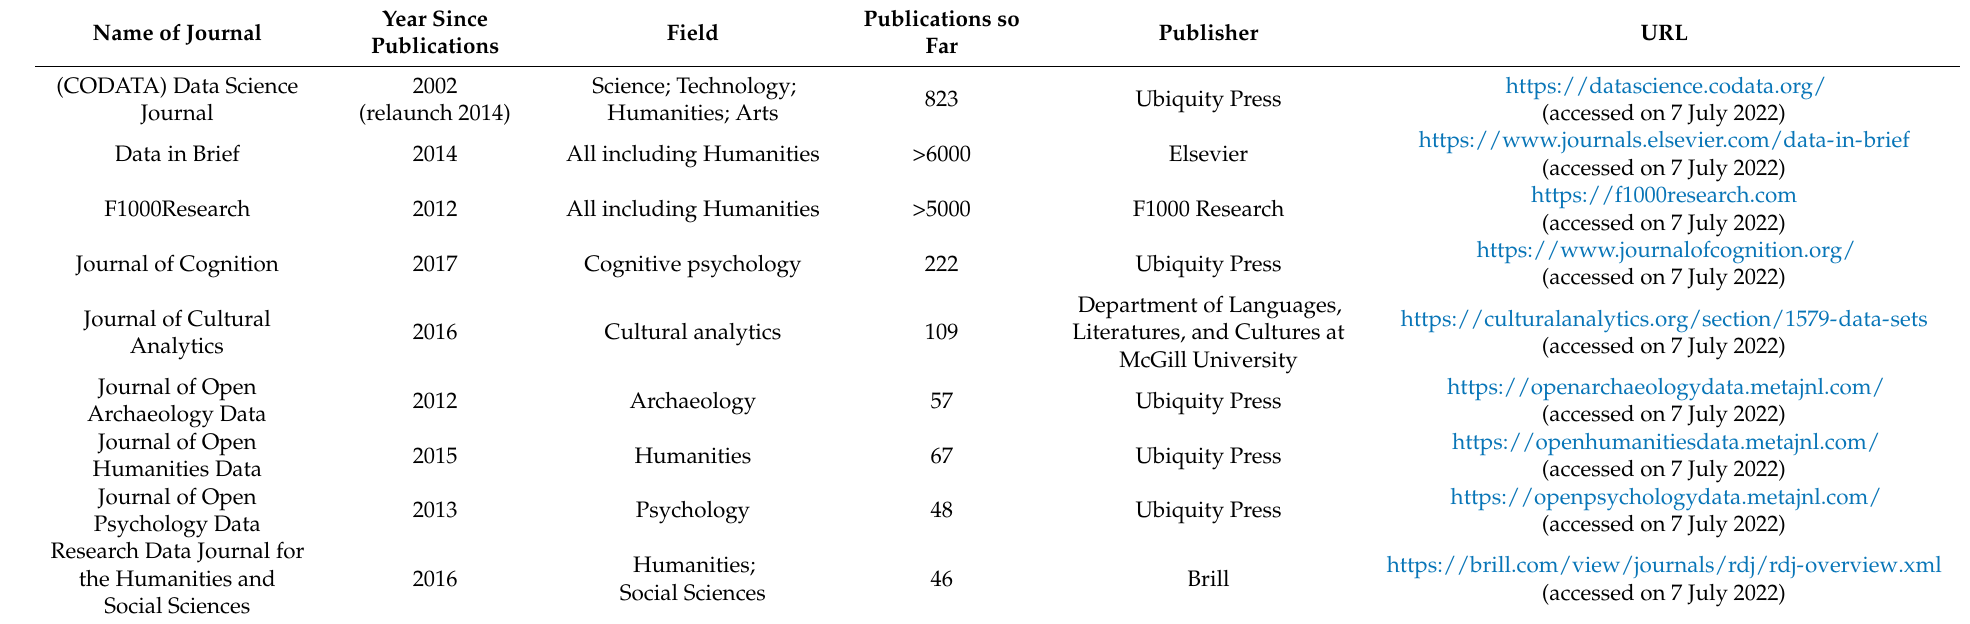
Table 1. Overview of data journals whose scope includes humanities and social science